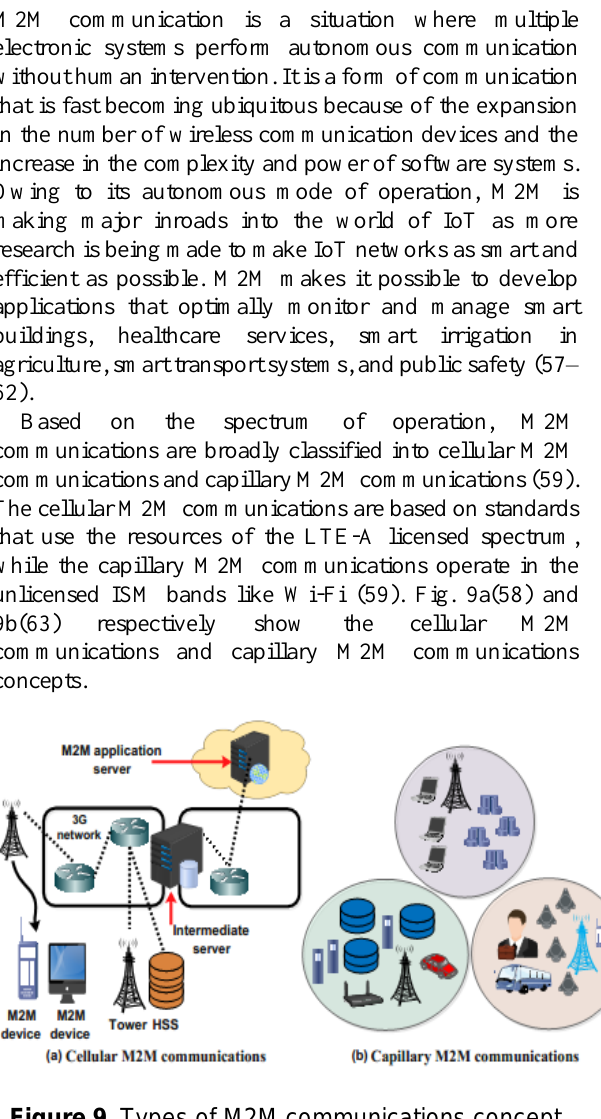
Figure 9. Types of M2M communications concept